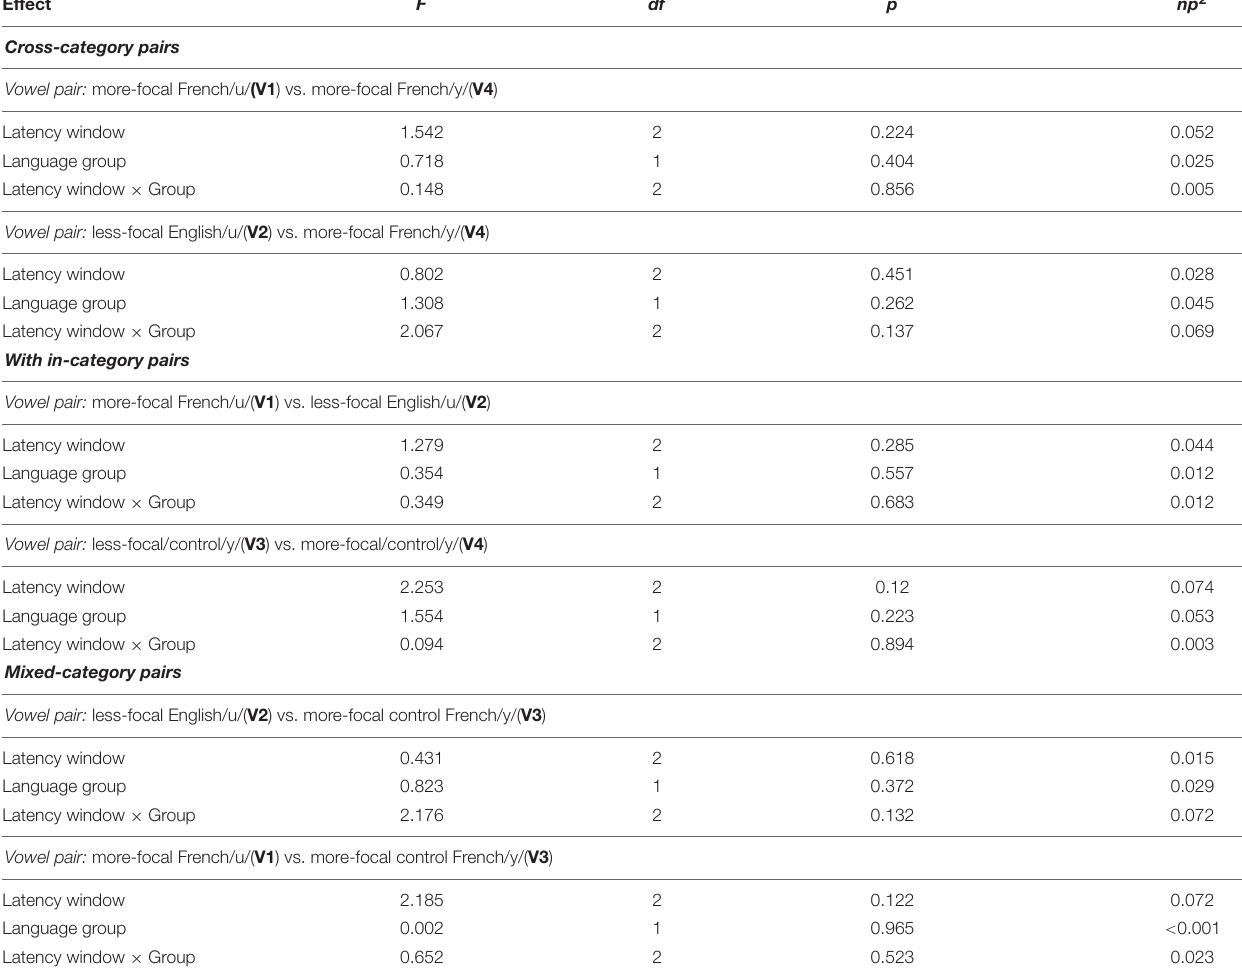
TABLE 3 | Mixed ANOVA on MMN Amplitude difference (MMN minus reversed MMN) for each stimulus type ( cross-category vs. within-category vs. mixed-category ). Effect F df p np 2 Cross-category